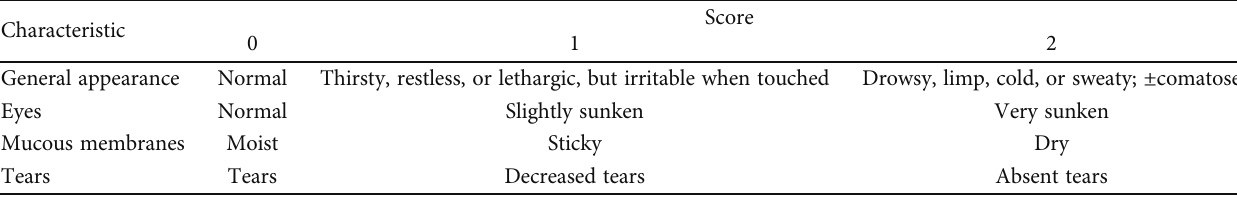
Table 1: The Clinical Dehydration Scale (CDS).